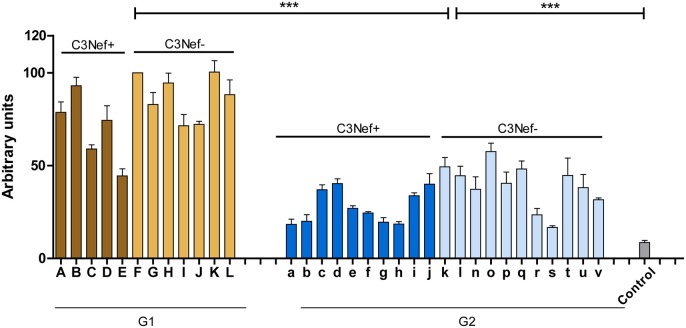
C3G patients presenting with autoantibodies to the C3-convertase. Thirty-three autoimmune patients with C3G with autoantibodies that bind to the in vitro assembled C3 convertase were identified in the Jena C3G cohort. Based on the binding intensity of autoantibodies to the in vitro assembled C3-convertase patients with high and low binding intensities are identified. Separated in group 1 with high/more C3-convertase binding antibodies and group 2 with weak/less binding antibodies. Each group includes patients who score positive in a C3Nef assay as well as C3Nef negative patients. Cut off was set at arbitrary units of 8.5 (average background binding level of 44 control sera). G1 to G2 and G2 to controls (***p < 0.001).